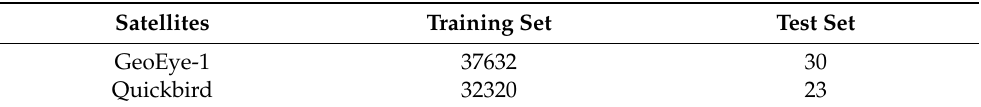
Table 3. Dataset